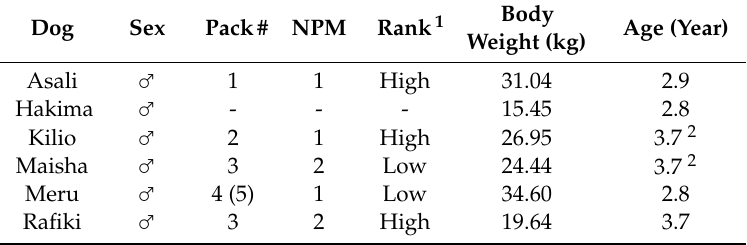
Table 1. Sex, pack membership, number of pack members (NPM), rank estimation (high or low) of social hierarchy, average body weight, average age when tested, and kinship of dog subjects. Body Age (Year) Dog Sex Pack# NPM Rank 1 Weight (kg) Asali 1 1 ♂